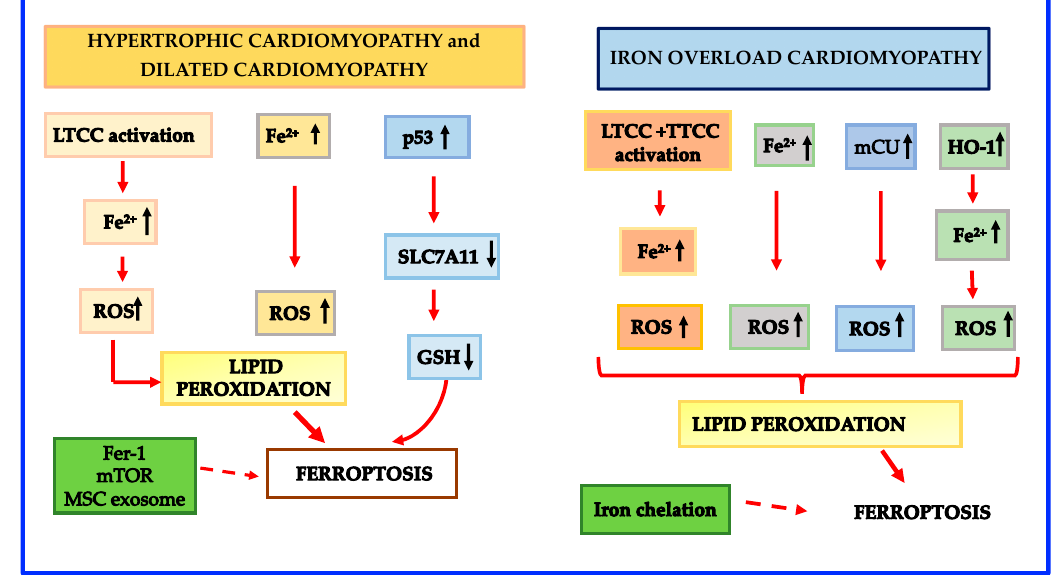
Figure 3. Schematic mechanisms leading to ferroptosis in Hypertrophic, Dilated and Iron overload cardiomyopathies. Abbreviations: GSH: reduced glutathione; HO-1: heme oxygenase-1; LTCC: L- type Ca 2+ channel; mCU: mitochondrial Ca uniporter; ROS: reactive oxygen species; SLC7A11: so- lute carrier family 7a member 11 subunit; TTCC: T-type calcium channel. Legend: dotted arrows = inhibition of ferroptosis.